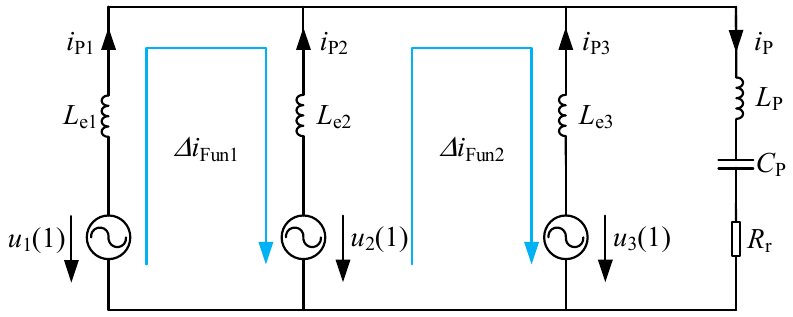
Figure 5. The equivalent circuit of the IPT system with the series-parallel resonant tank.